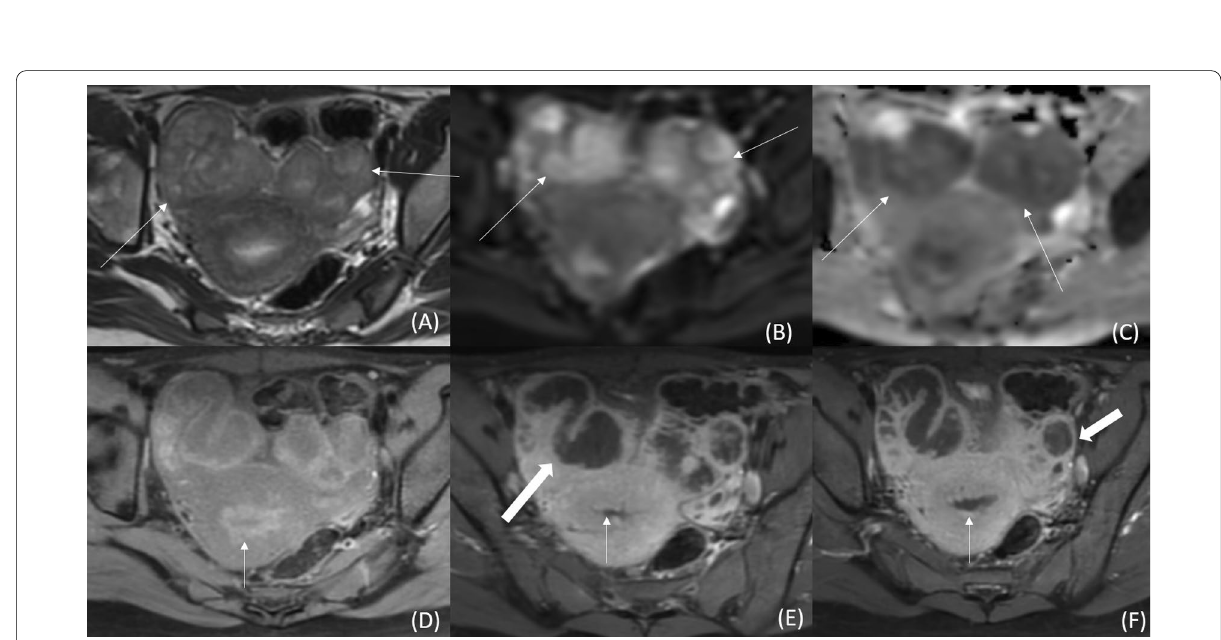
Fig. 14 Female genital tuberculosis—endometritis and bilateral pyosalpinx. MRI pelvis of a 16-year-old girl shows dilatation of bilateral fallopian tubes with hyperintense contents and fluid in endometrial cavity on T2W image ( A ), contents of bilateral fallopian tubes show restriction ( B and C ), T1W fat-supressed ( D ) and T1W contrast-enhanced images ( E , F ) show irregularity of endometrial lining (thin arrow) and thick